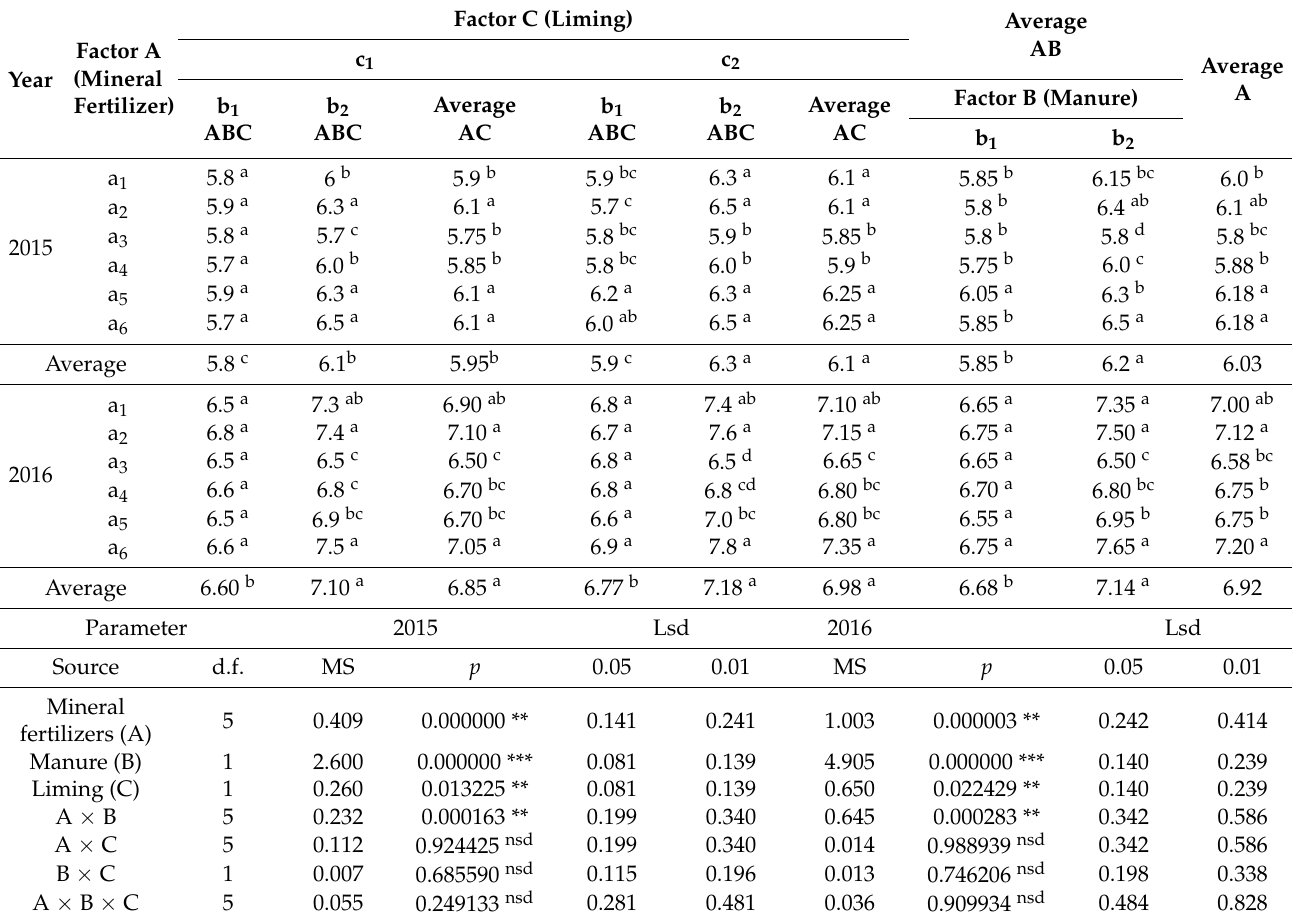
Table 4. The influence of the applied fertilizers on average tuber number per plant.